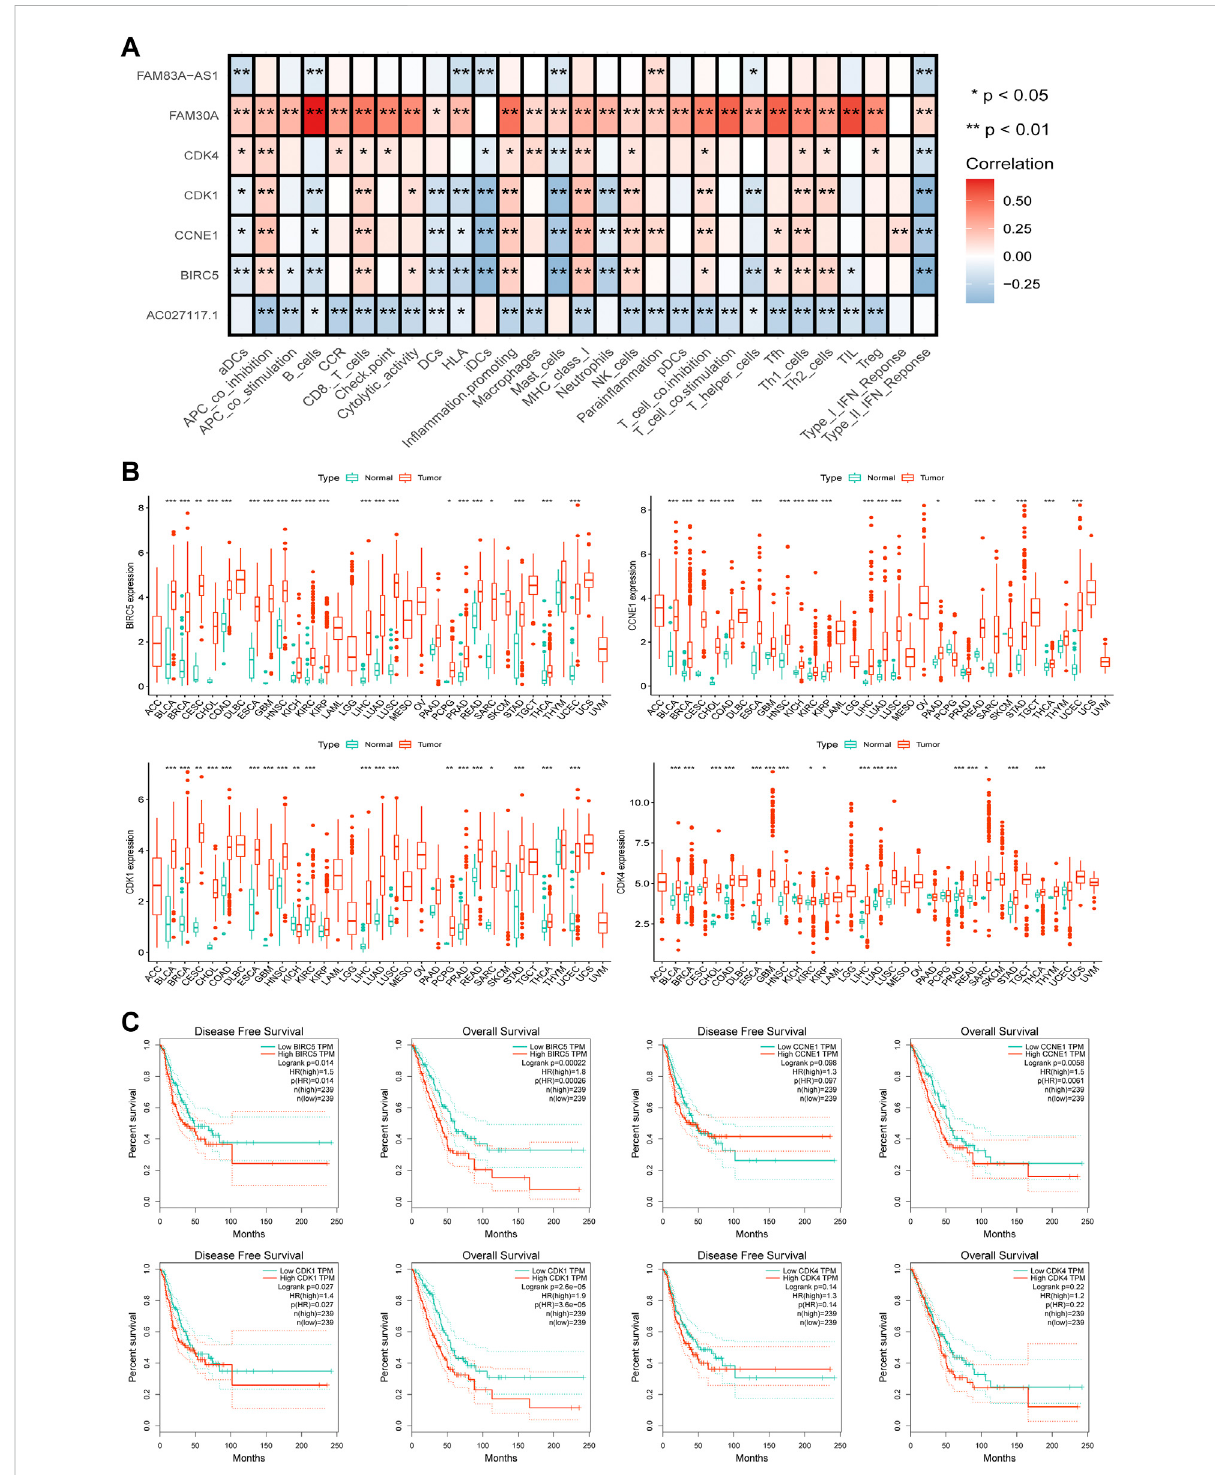
FIGURE 8 Further analysis of hub genes. (A) The correlation analysis between the hub genes and lncRNAs and immune functions in LUAD. (B) The pan- canceranalysisoffourhubgenesinTCGA. (C) The disease-free survival (DFS)andoverallsurvival(OS)analysis curvesofthefourhub